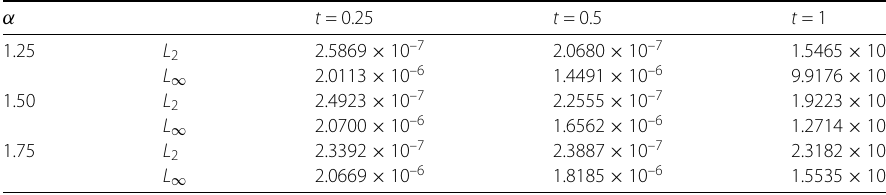
Table 2 Error norms for Problem 1, with N = 80 and (cid:2) t = 0.001 α t =